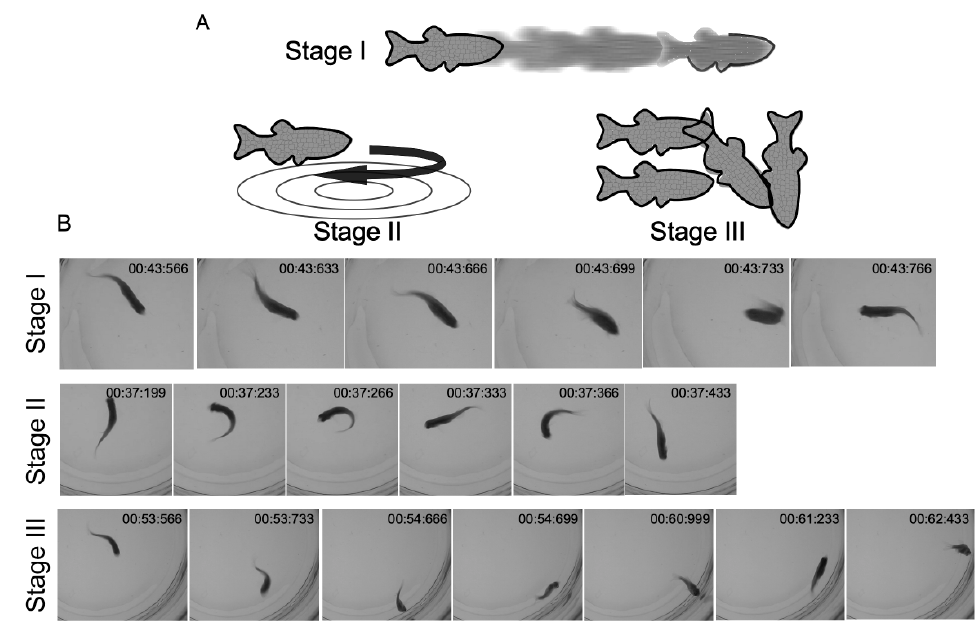
Figure 5. Seizures induced by flashlights in the hcn2b − / − mutant. During dark-light transitions, about 7% of adult hcn2b − / − mutants exhibited behavioral seizure activity. ( A ) First, fish increased their swimming activity (Stage I); then, they showed a rapid “whirlpool-like” circling swimming behavior (Stage II); finally, they exhibited a series of brief clonus-like convulsions that led to a loss of posture and immobility (Stage III). ( B ) Snap shot sequences of each stage of the seizures caused by flashlight in the hcn2b − / − mutant zebrafish. Images taken from Video S2.